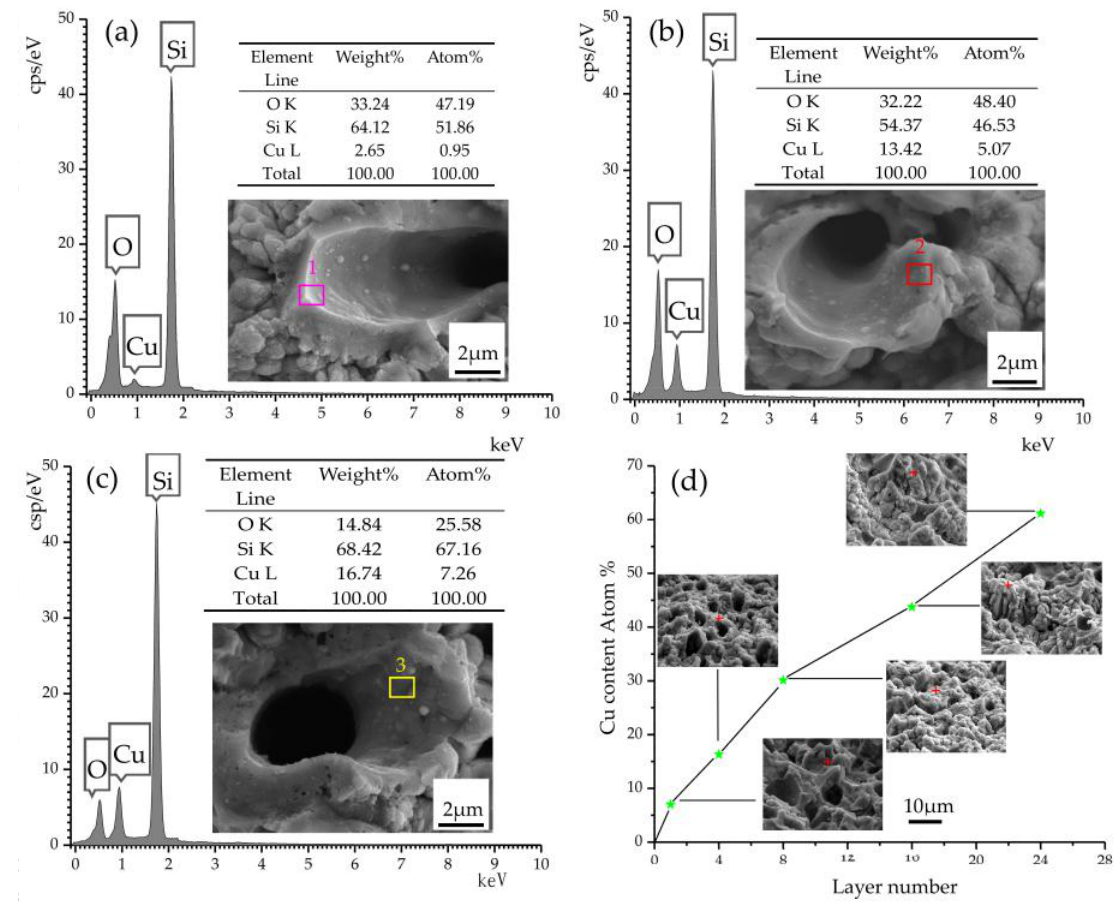
Figure 6. SEM image and EDS analysis of deposition, ( a ) HV single discharge deposition in gas atmosphere, ( b ) HV- µ EAM in gas atmosphere, ( c ) HV- µ EAM under the condition of blowing nitrogen, and ( d ) Cu contents with di ff erent deposition